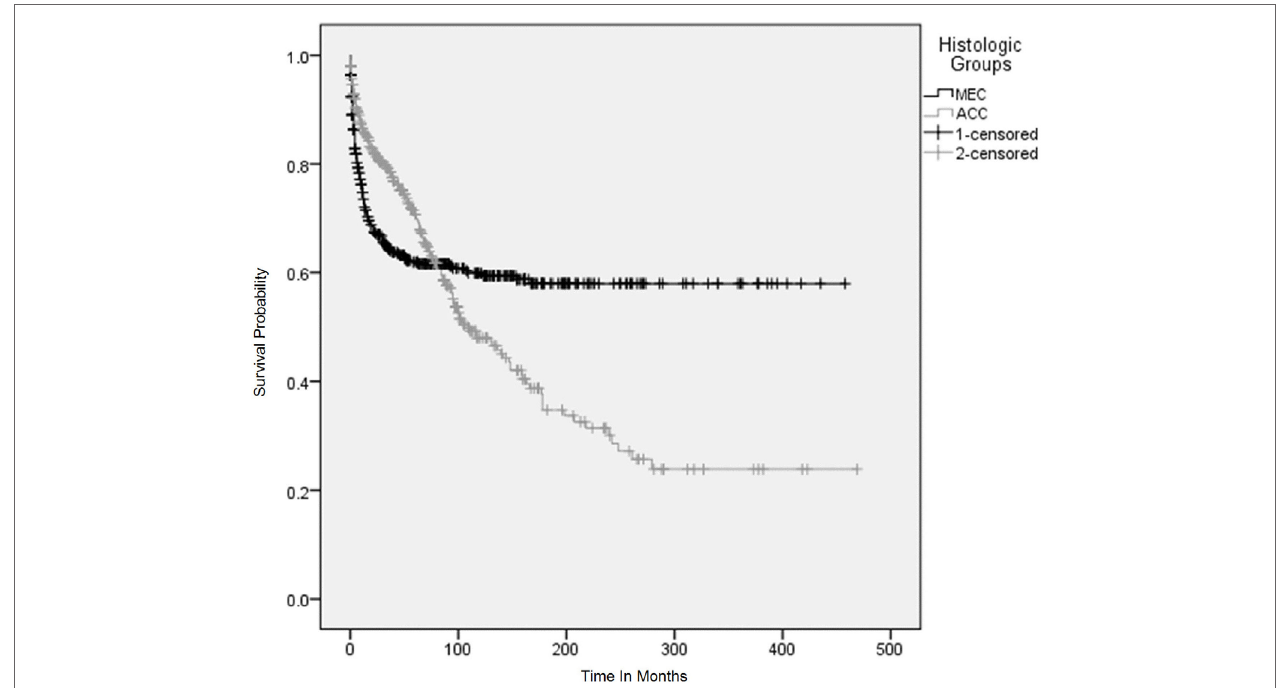
FigUre 4 | Overall survival using Kaplan–Meier (KM) method according to histological subtypes. The KM survival curves for patients with adenoid cystic carcinoma and mucoepidermoid carcinoma converged after 5 years and crossed each other between 7 and 8 years after the initial diagnosis and continued to diverge for 25 years and became parallel